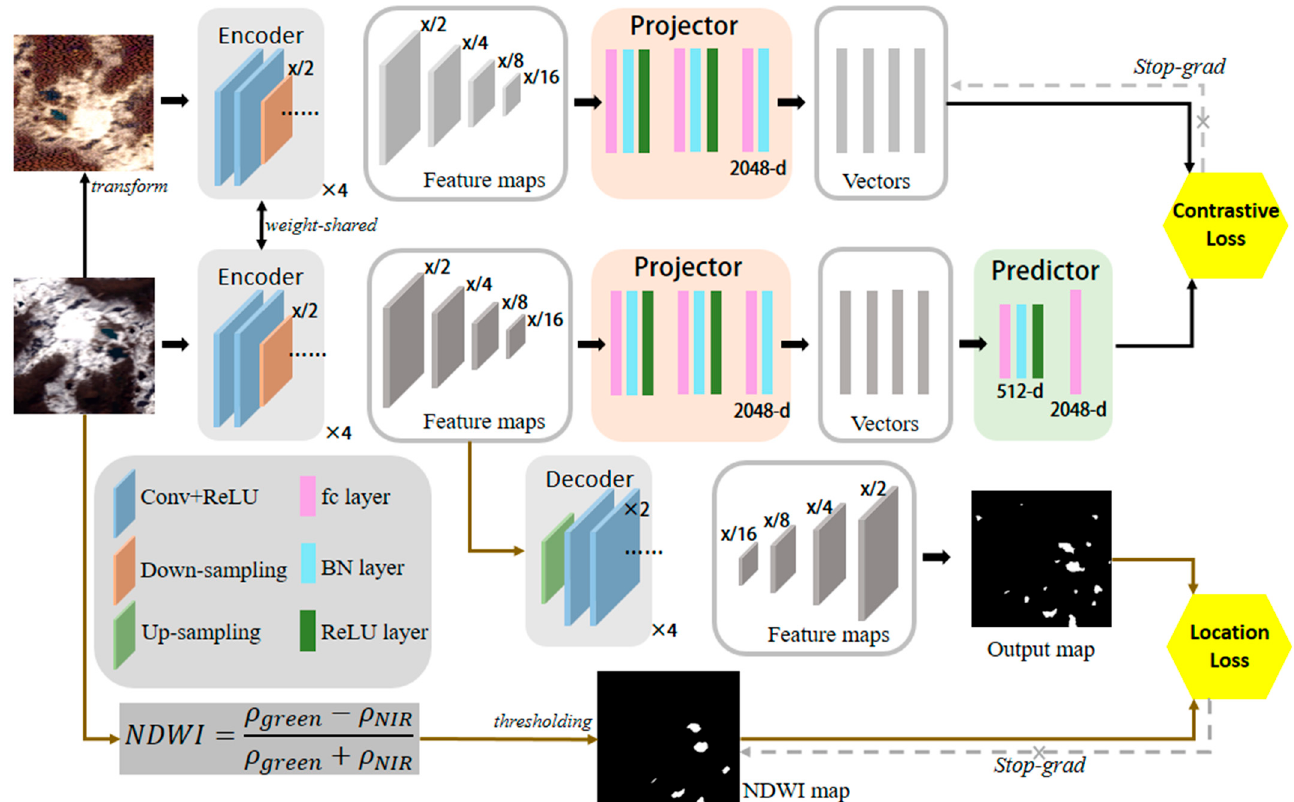
Figure 2. The architecture of the proposed SimGL. It consists of two parts: one takes the RS image and its augmentations as input pairs for a Siamese network, which generates a set of feature maps at different scales. Then applying the prediction layer on projected features from one branch to predict the transform features from another branch, and we use a contrastive loss to measure the similarity between the two features. Another part only takes the RS image as input, then a location loss was calculated between the output map (generated by decoding the multi-scale features) and location cues (generated by thresholding the NDWI map) to constrain the segmentation